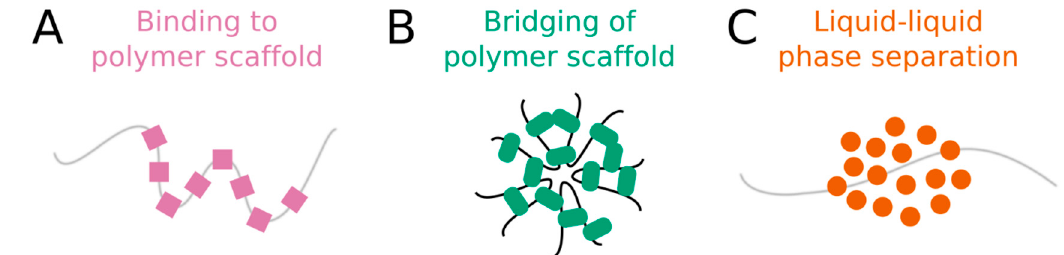
Figure 1. Membraneless compartments can form through at least three distinct mechanisms: ( A ) binding, ( B ) bridging, or ( C ) liquid-liquid phase separation.